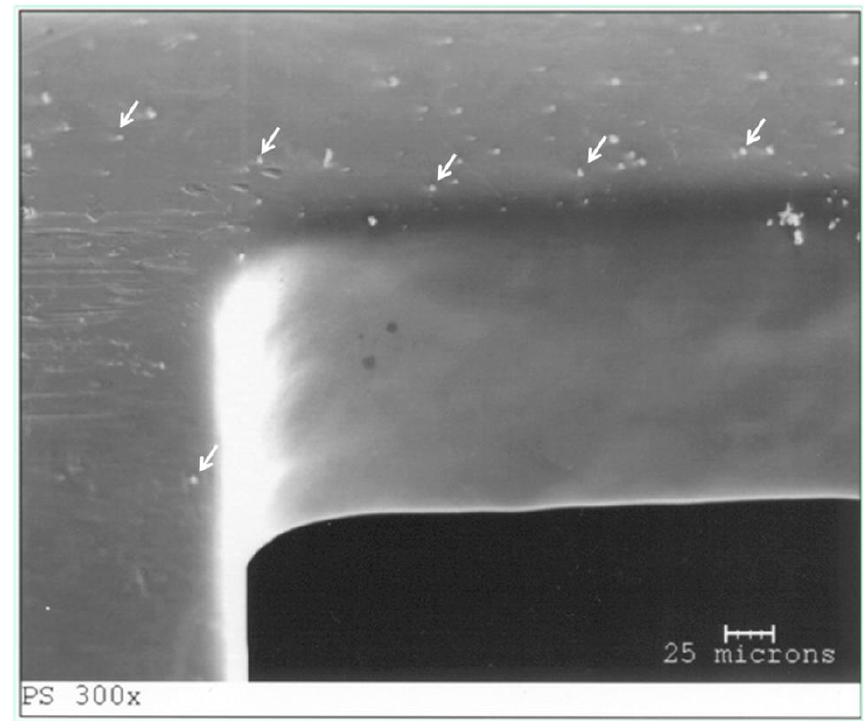
Figure 4. Scanning electron micrograph of a stainless steel stent, illustrating size and prevalence of surface asperities (six example asperities are marked with white